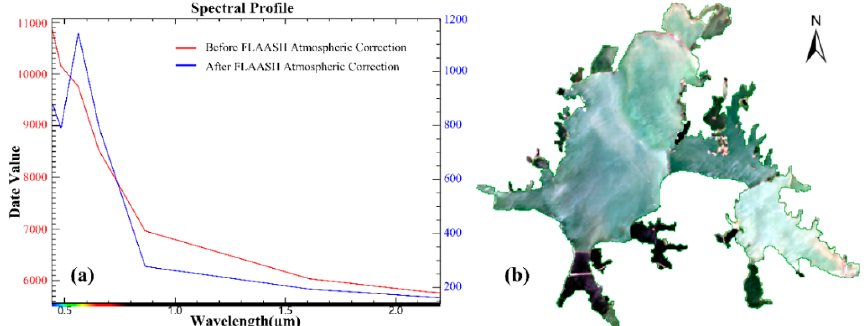
Figure 2. ( a ) Water spectral curves before and after FLAASH Atmospheric Correction. ( b ) A true-color composite Landsat-8 OLI image acquired on 18 April 2016 after an extraction of the water body information.